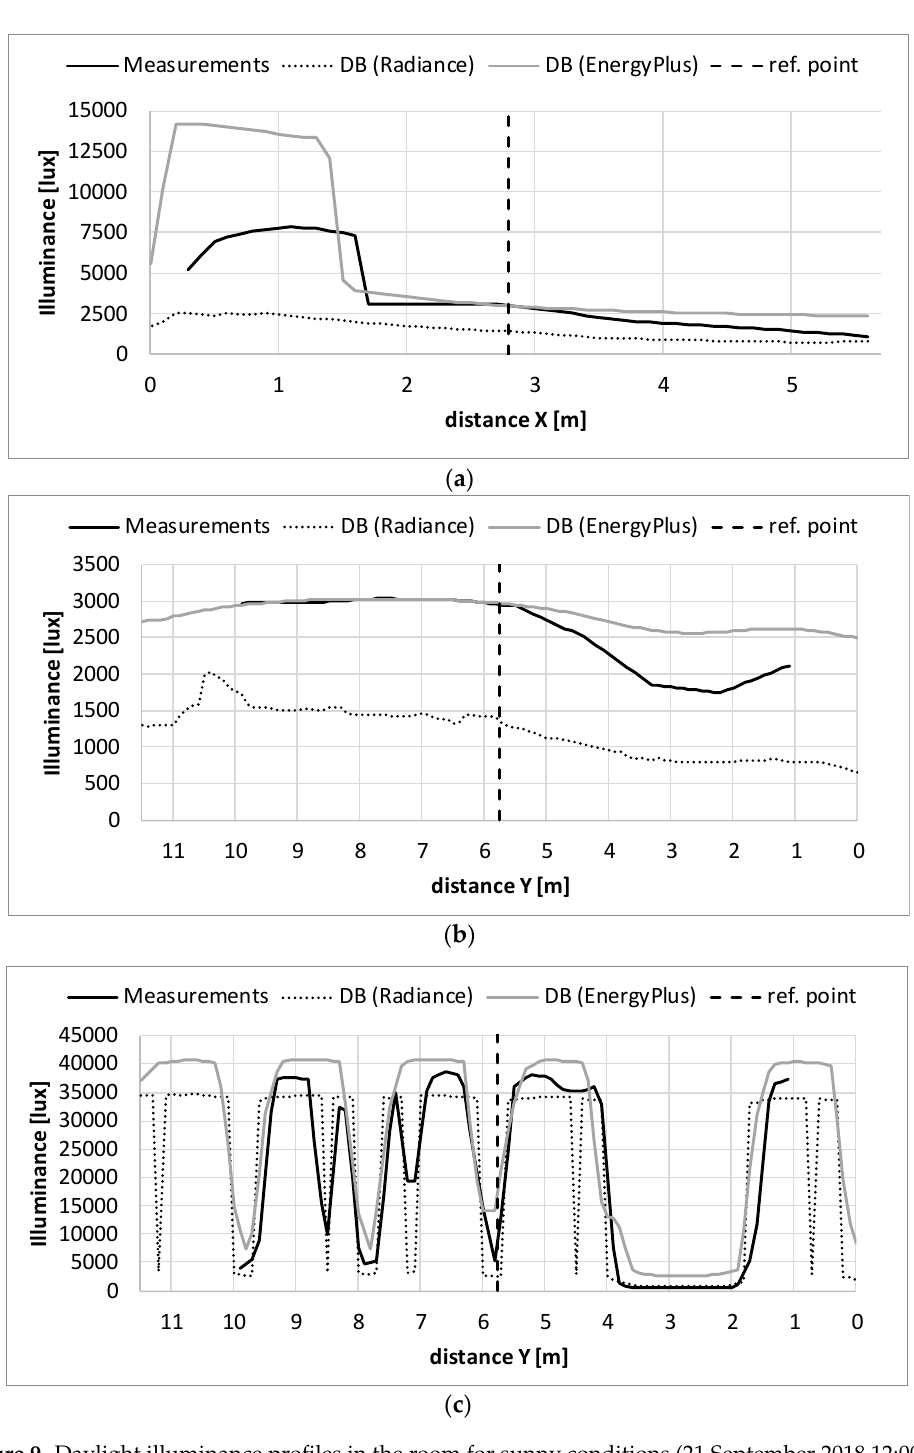
Figure 9. Daylight illuminance profiles in the room for sunny conditions (21 September 2018 12:00) ( a )